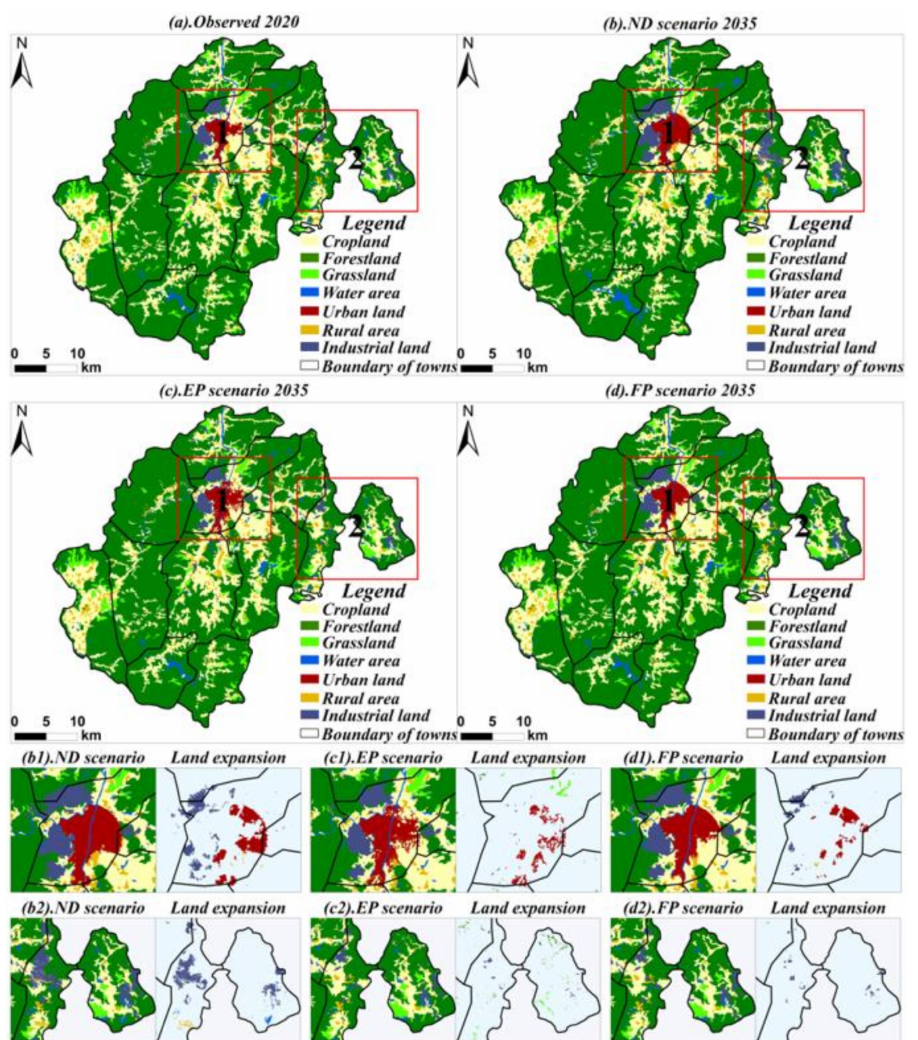
Figure 8. Simulated LULC patterns in 2035 and land expansion maps from 2020 to 2035 under different